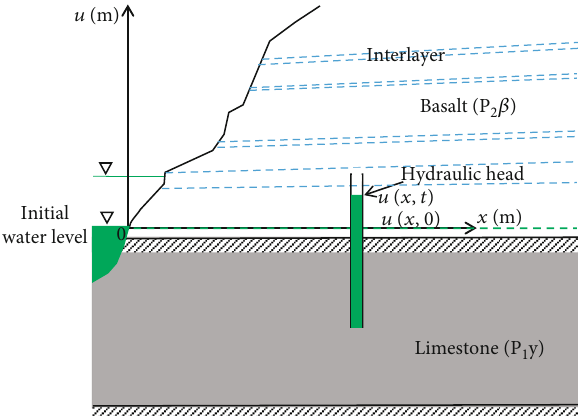
Figure 5: Generalized geology cross section of the river bank in the research area.